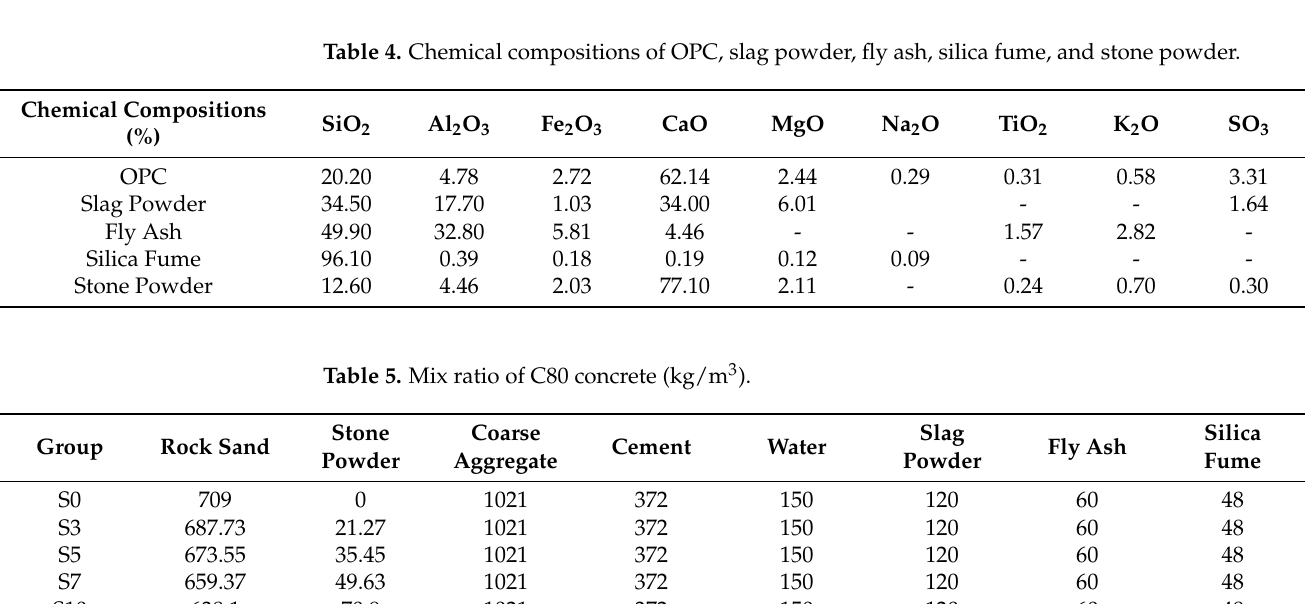
Table 2. Performances of water-reducing admixture.